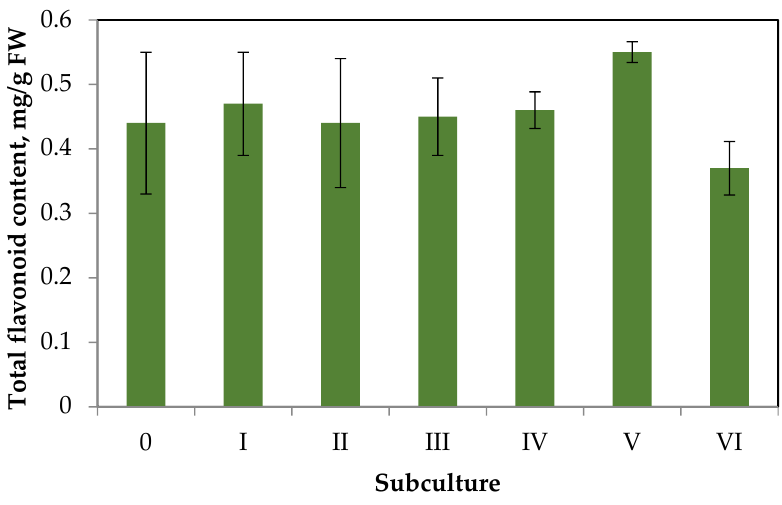
Figure 4. Dynamics of flavonoid accumulation in S. hortensis callus over six subcultures.